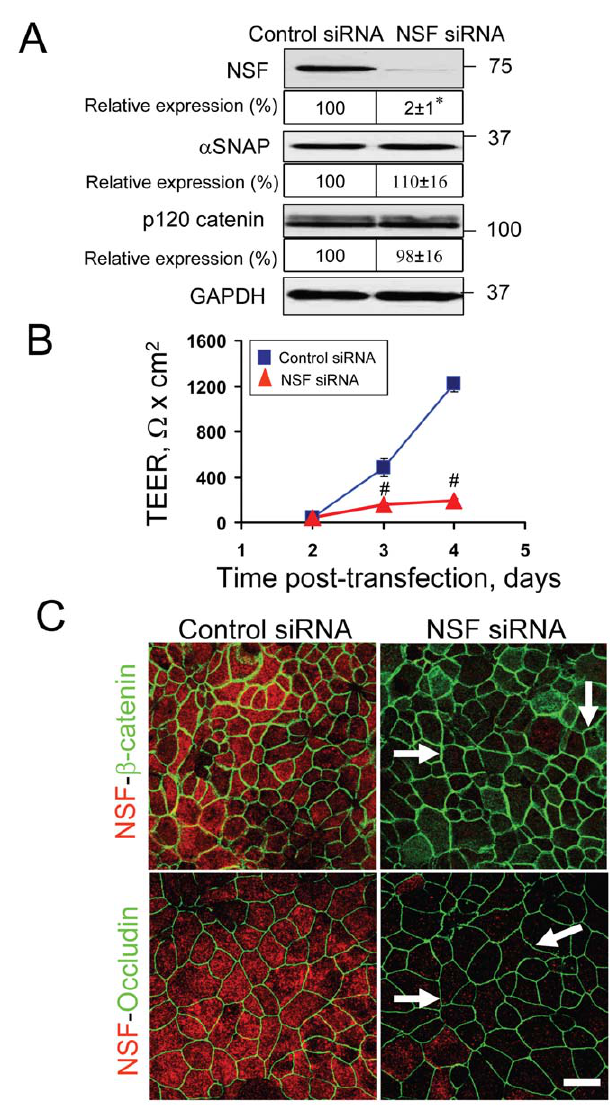
Figure 6. Downregulation of NSF does not phenocopy the major effects of a SNAP knockdown on epithelial junctions. ( A ) Immunoblotting analysis shows that NSF-specific siRNA efficiently decreases expression of the targeted protein without affecting a SNAP and p120 catenin protein levels. ( B ) TEER measurements demonstrate that NSF-depletion significantly attenuates formation of the paracellular barrier in SK-CO15 cell monolayers; *p , 0.05 compared to the control siRNA-treated group (n=3). ( C ) Immunofluorescence labeling shows normal AJ and TJ structure (arrows) in NSF-deficient SK-CO15 cells on day 4 post-transfection; *p , 0.05, # p , 0.01 compared to the control siRNA-treated group (n=3). Scale bar, 20 m m.